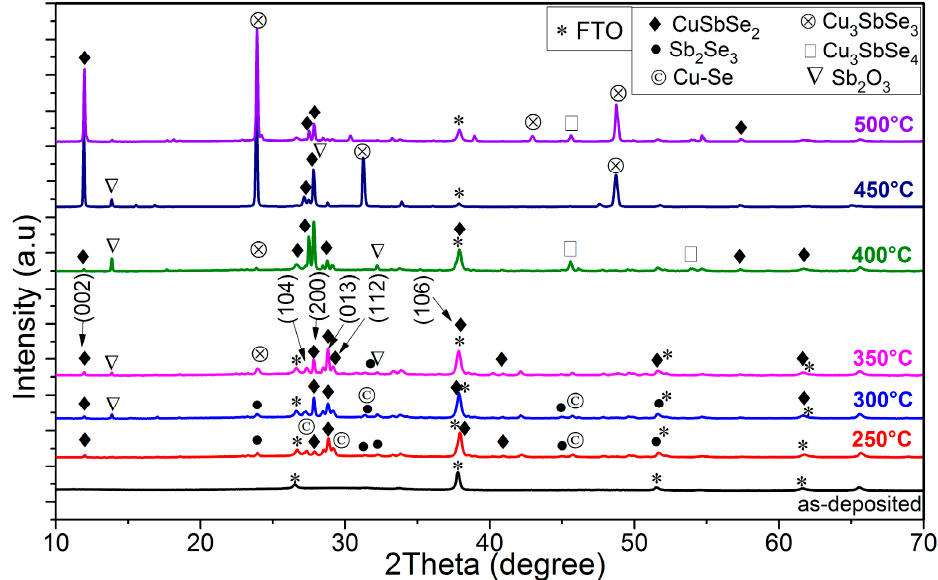
Figure 4. XRD patterns of the CuSbSe 2 thin films deposited at − 0.4 V/SCE during 30 min and annealed at different temperature for 10 min in N 2 atmosphere. (*) = peaks from the FTO substrate.